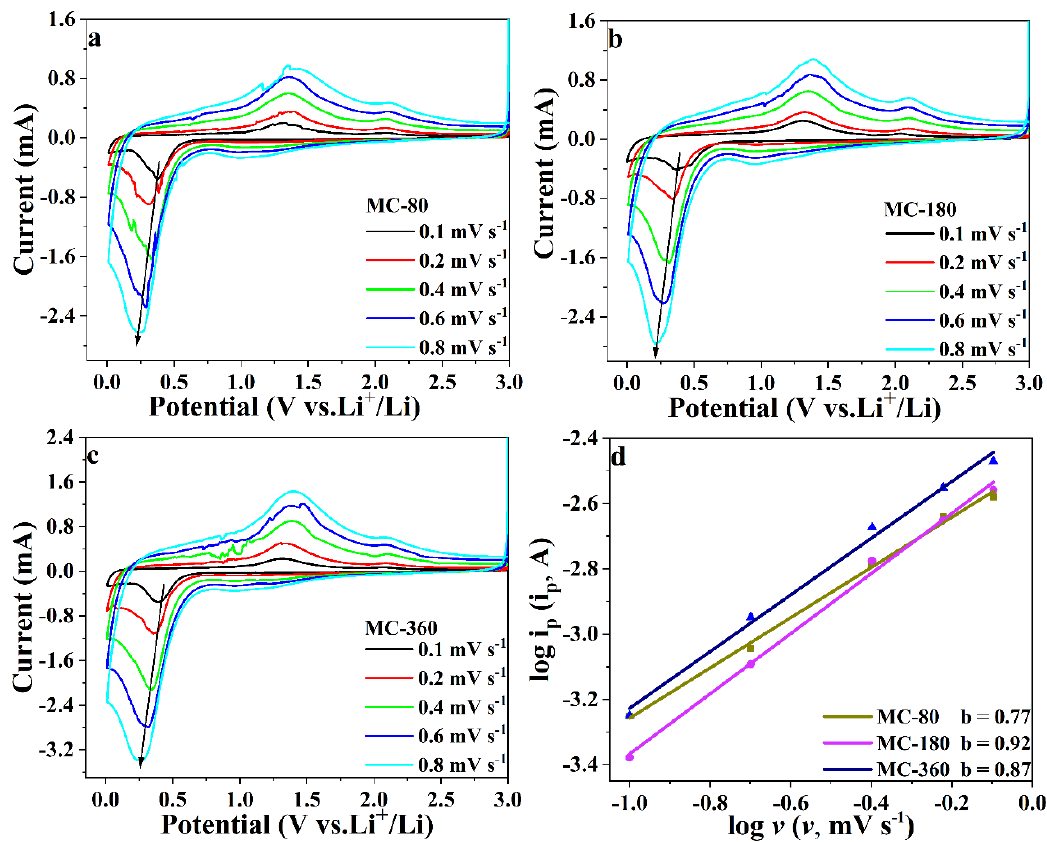
Figure 8. CV curves of MC-80 ( a ), MC-180 ( b ), and MC-360 ( c ) at different scan rates, and the relationship between the log ( i ) and log ( v ) to determine the b -values ( d ).